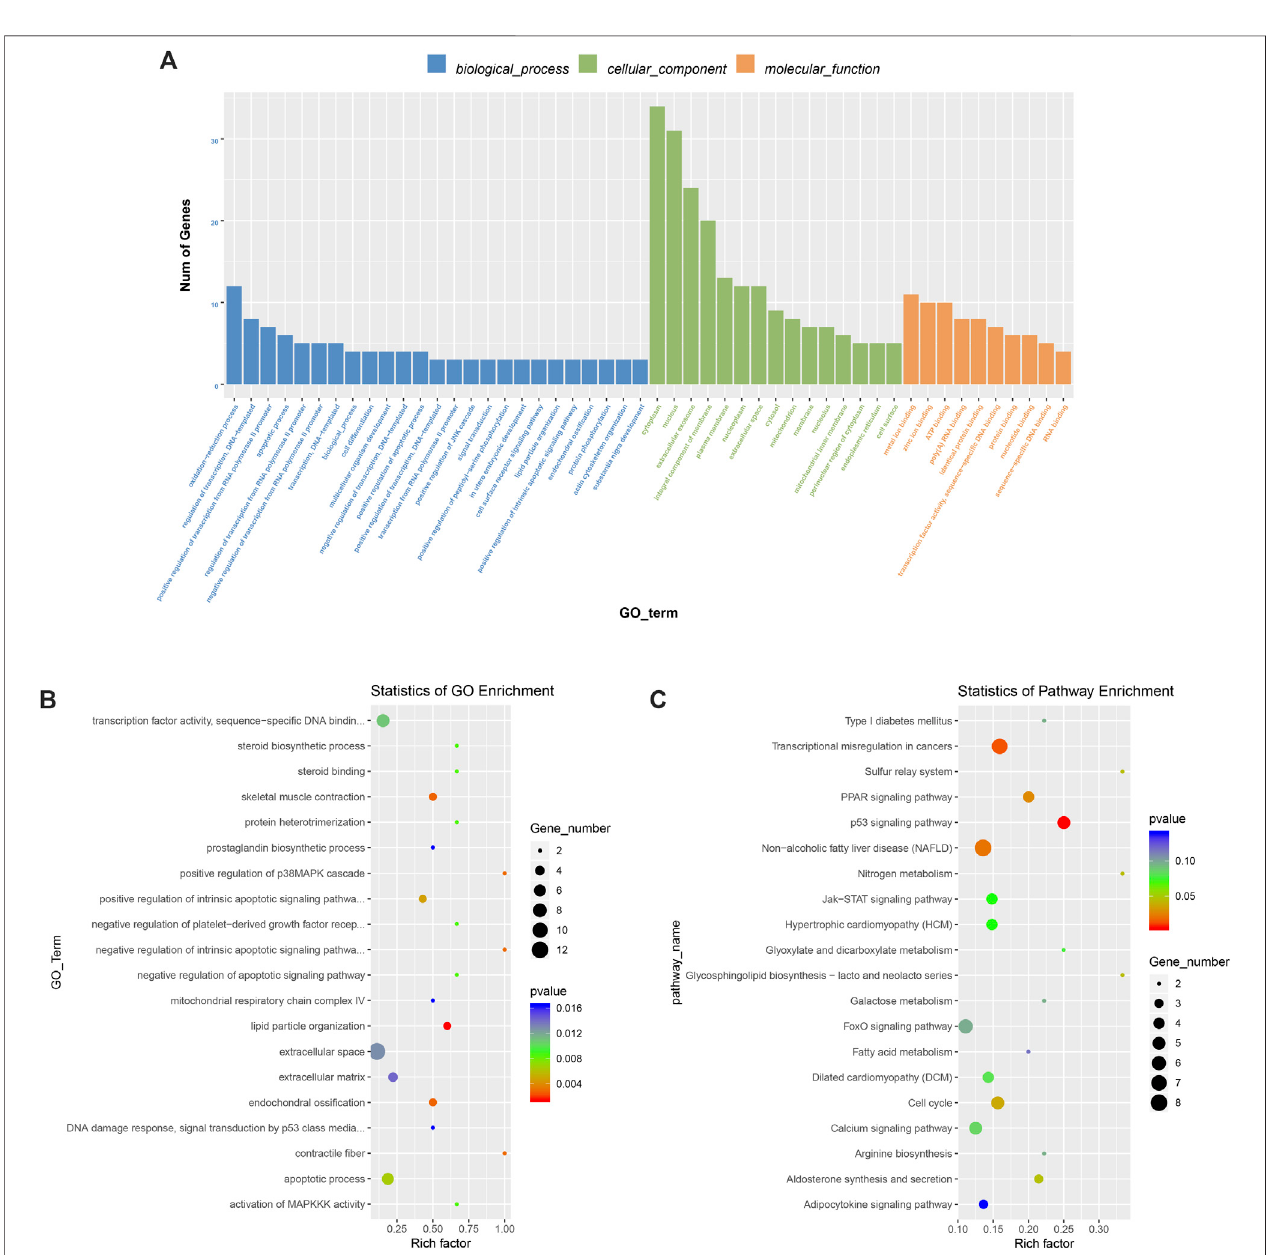
FIGURE6 | M6A differential peak geneontology enrichmentanalysisand KEGG pathway analysis. (A) Main enrichment 3and meaningful GOentries ofm6Apeak. (B) The fi rst 20 items have signi fi cantly enrichment GO terms. (C) The fi rst 20 enriched pathways of the m6A peak.